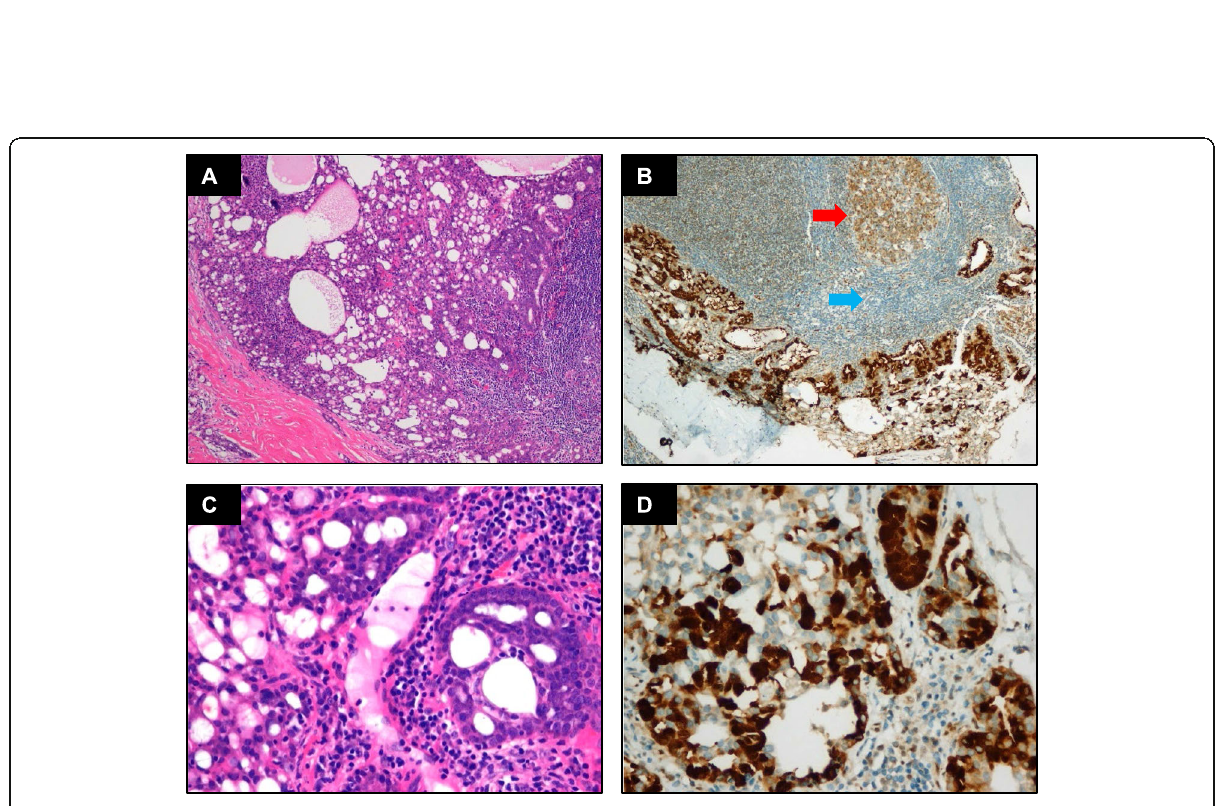
Fig. 4 ( A ) Histomorphology of a ACC with paucity of zymogen granules. ( B ) Strong cytoplasmic LMO2 staining is seen in the neoplastic cells. The nuclear expression of LMO2 in the germinal center B cells may serve as internal positive controls (arrow). ( C - D ) Higher power